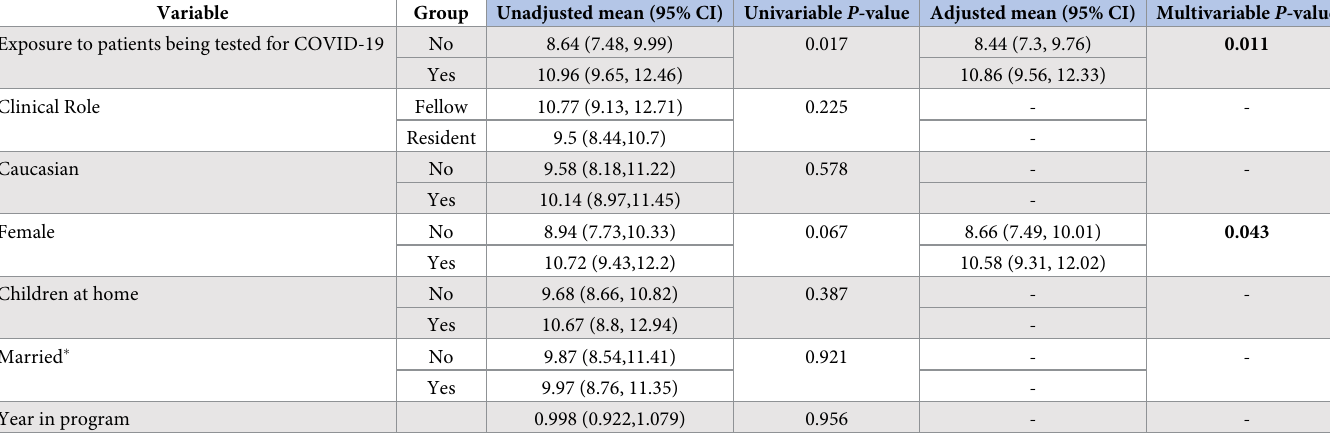
Table 2. Univariable and multivariable negative binomial regression models for outcomes related to stress.